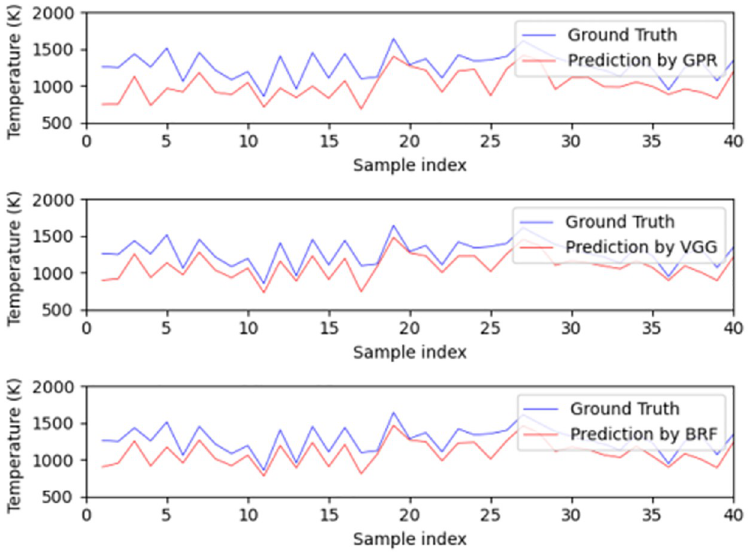
Fig 5. Model generalization performance for the prediction of average temperature of non-uniform-profile spectra. The top, middle and bottom subplots are the predictions of GPR, VGG and BRF,